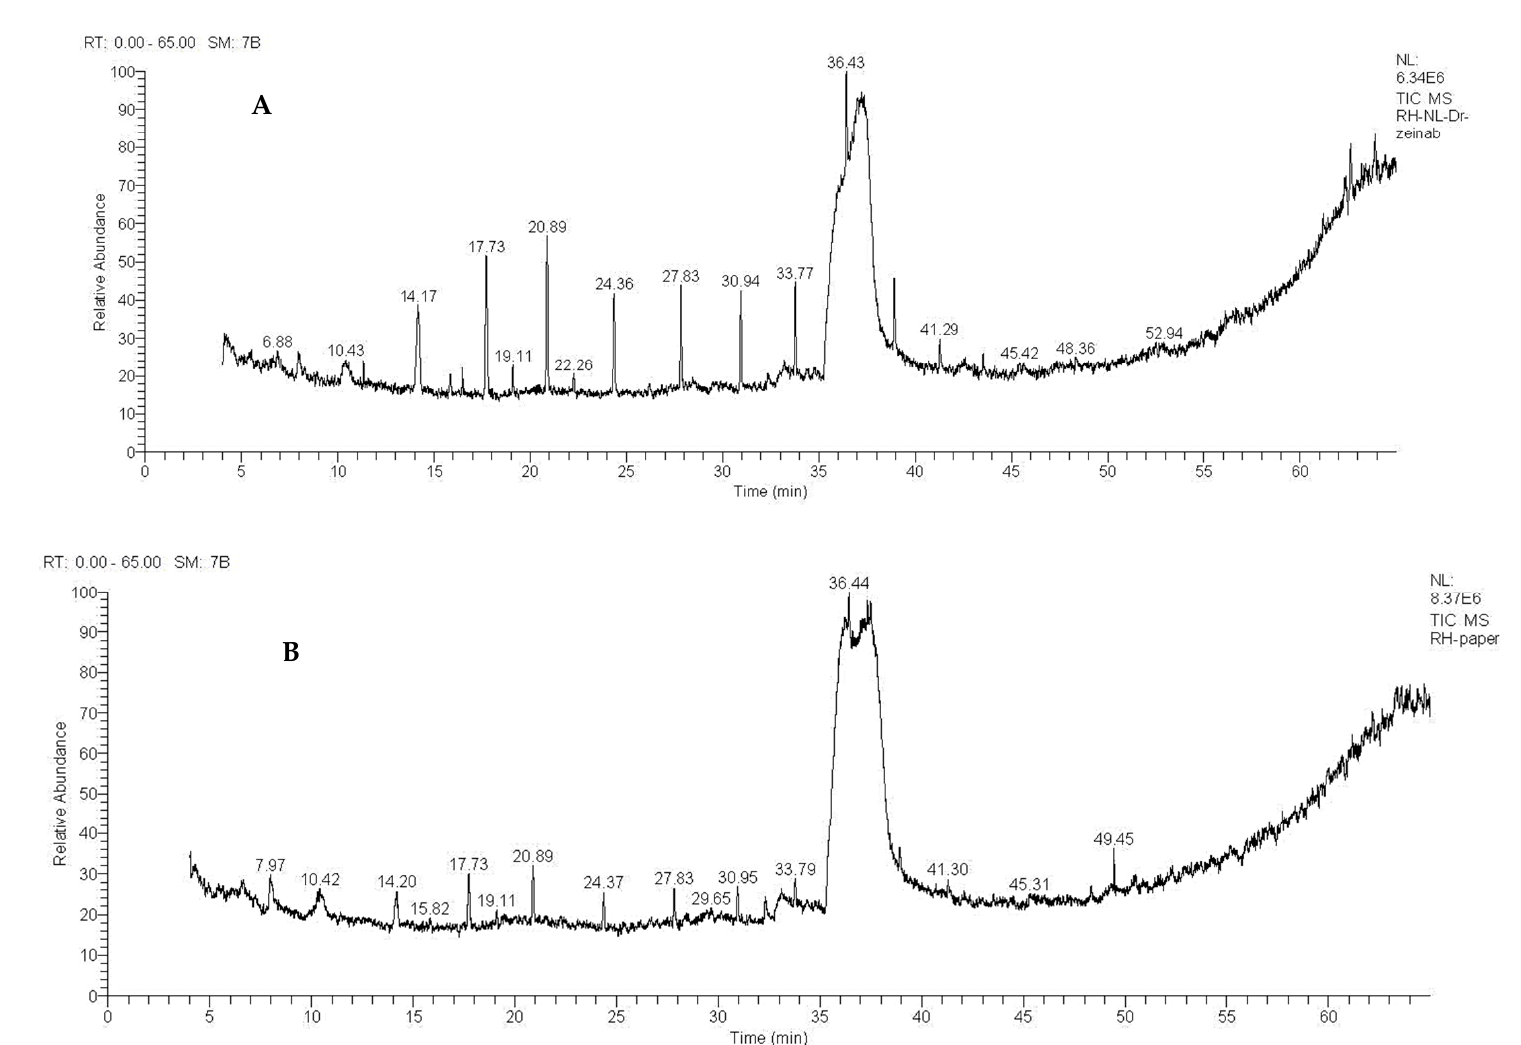
Figure 2. Gas chromatography/mass spectrometry spectra of Rhizophora mucronate . ( A ) Stem extract. ( B ) Leaf extract.